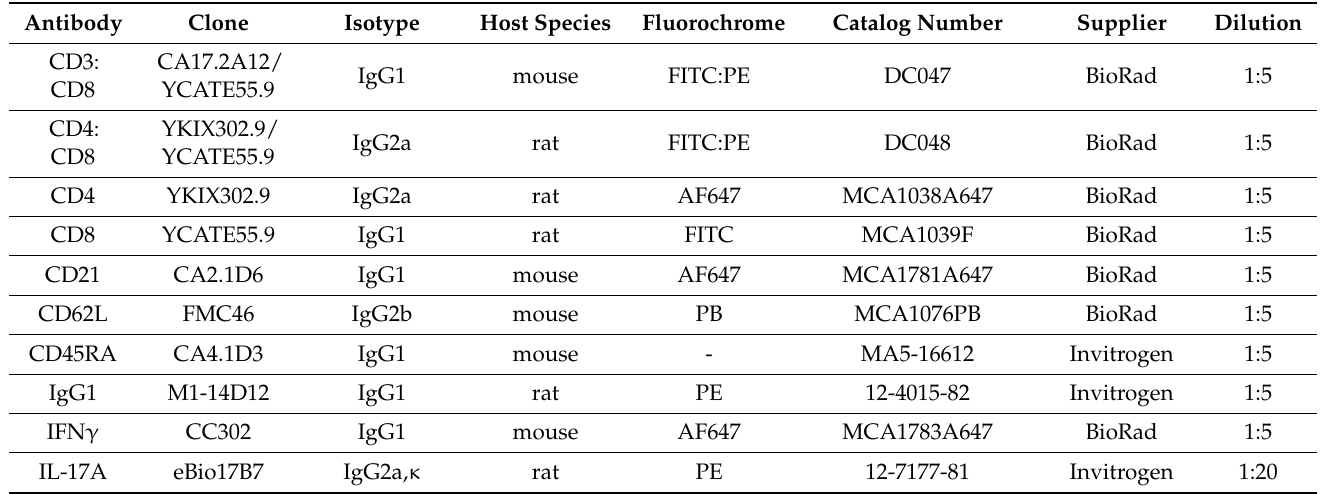
Table 1. List of monoclonal antibodies used for labeling peripheral blood mononuclear cells (PBMCs) for flow cytometry. Abbreviations: FITC—Fluorescein isothiocyanate, PE—Phycoerythrin, AF647— Alexa Fluor 647, PB—Pacific